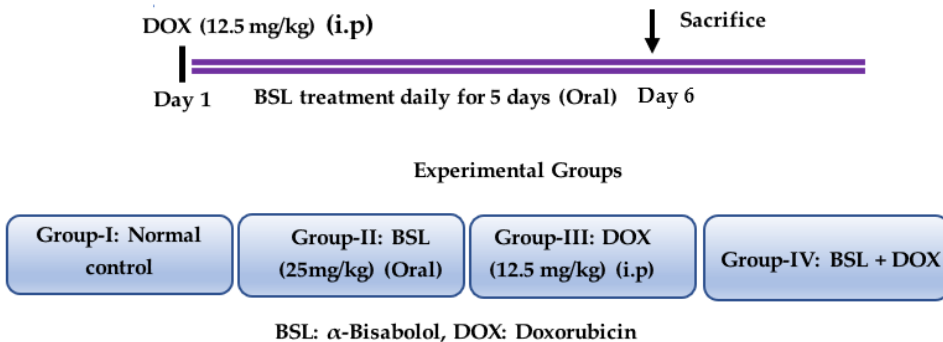
Figure 1 . Study design and experimental groups . Figure 1. Study design and experimental